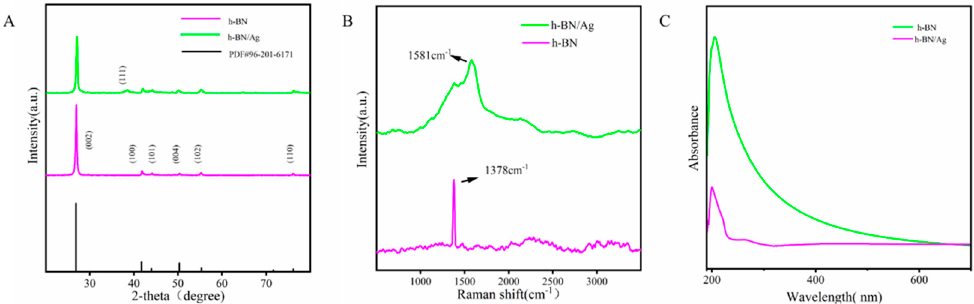
Figure 2. ( A ) XRD patterns of h-BN and h-BNNs/AgNPs ( B ) Raman spectra of h-BN and h- BNNs/AgNPs ( C ) UV spectra of h-BN and